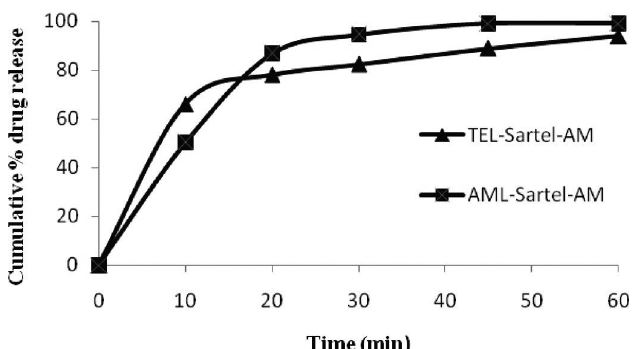
FIGURE 3- In vitro dissolution profile of Sartel-AM tablets in SGF media at 75 rpm (n=12). TABLE II - Data obtained from stability studies % Amount of drug found